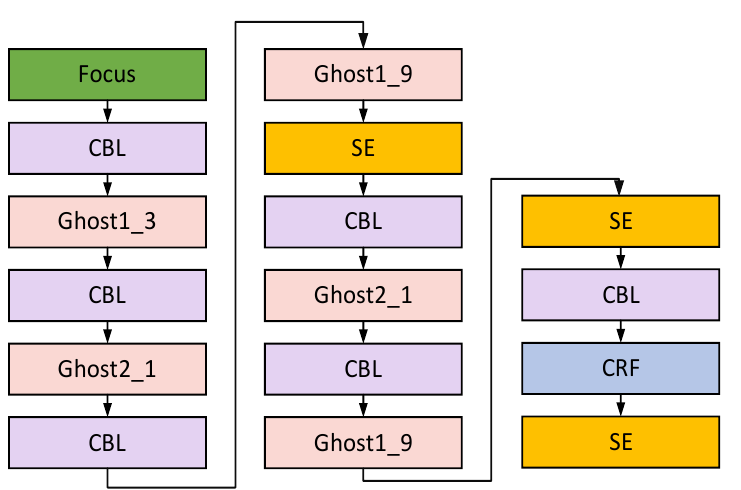
Figure 2. Improving the backbone network of YOLOv5.